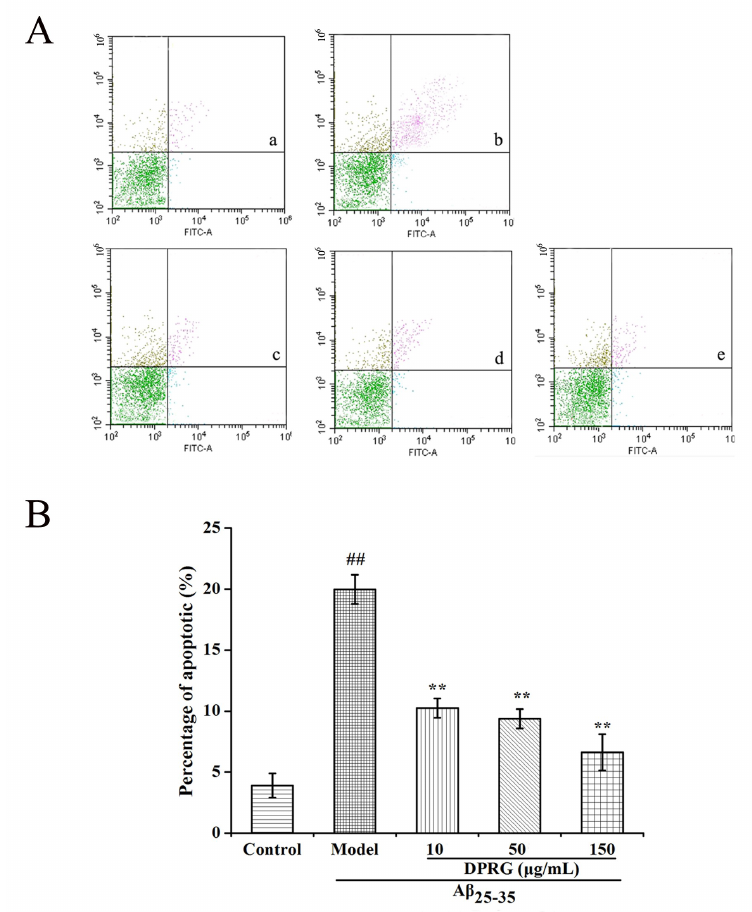
Figure 5. E ff ect of DPRG on apoptosis in PC12 cells induced by A β 25–35 . Cell apoptosis was Figure 5. Effect of DPRG on apoptosis in PC12 cells induced by Aβ 25-35 . Cell apoptosis was identified by annexin-V/propidium iodide (PI) double-staining assay ( A ). PC12 cells were incubated in